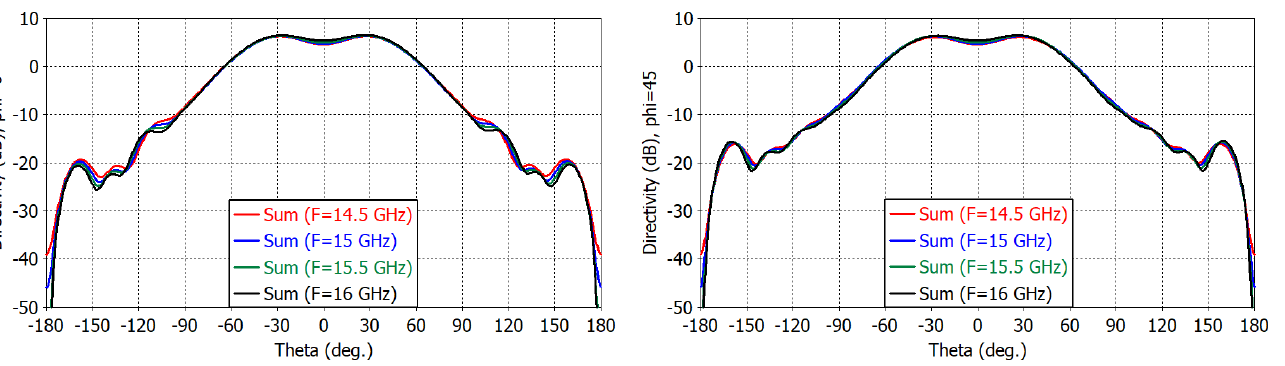
Figure 8. RHCP phase patterns of the sum channel.